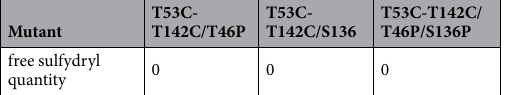
Table 1. The quantity of the free sulfydryl in the mutants.